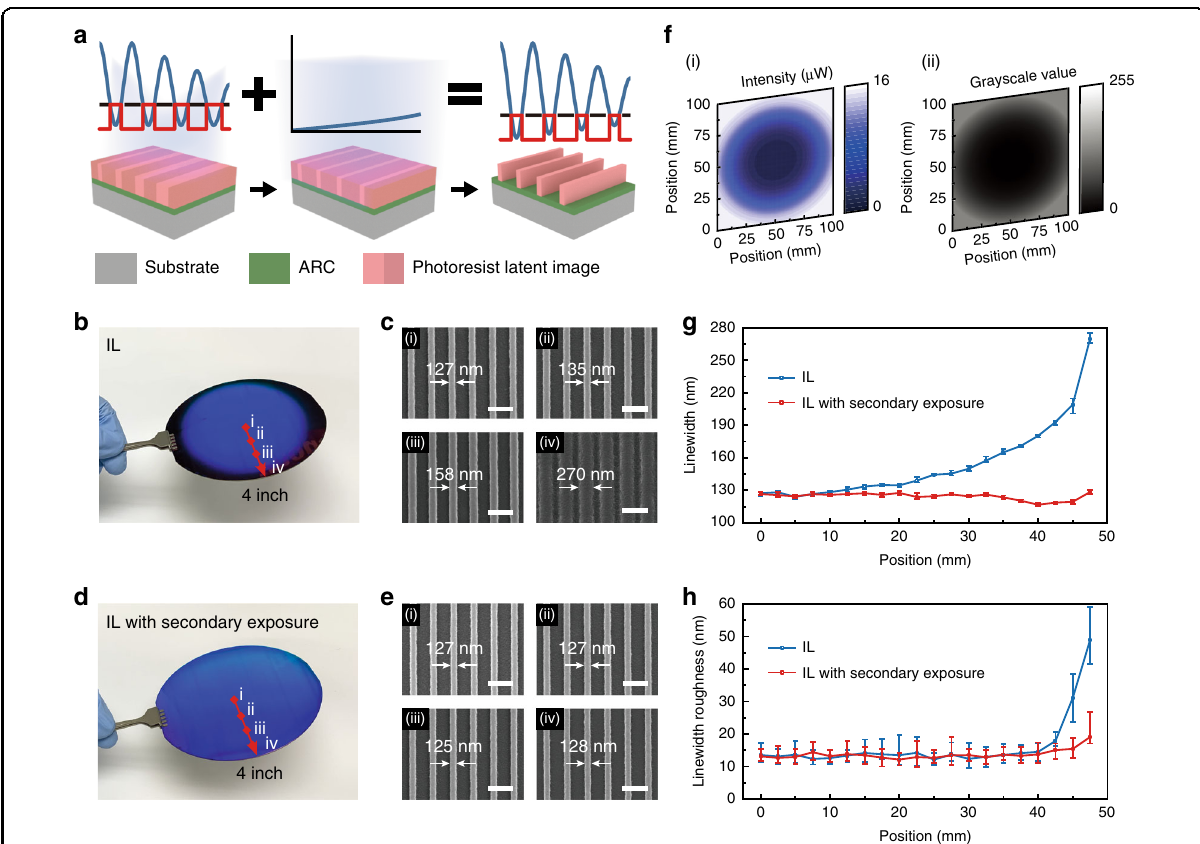
Fig. 4 Uniform 4-inch wafer-scale patterning using IL-GPSE. a Schematic of uniform nanopatterning using secondary exposure to compensate the linewidth variation due to the non-uniform laser beam intensity during IL. b Photograph of IL-exposed 400-nm-period gratings over a 4-inch wafer with the diffracted blue light intensity gradually decreasing from the center to the edge. c SEM images taken in the labeled positions in b , showing a poor control of linewidth and roughness. d Photograph of 400-nm-period gratings over a 4-inch wafer using secondary exposure with a designed projected grayscale pattern after IL exposure, diffracting uniform blue light. e SEM images recorded in the labeled positions in g , showing the uniform linewidth and linewidth roughness. f The 4-inch (i) intensity distribution for linewidth tailoring and (ii) devised grayscale image transformed by the characterized relation between the digital grayscale value and projected light intensity via the UV projector. The comparisons of g linewidth and h linewidth roughness distributions over the radius of 4-inch wafers w/o the secondary exposure, respectively. Scale bars: 500